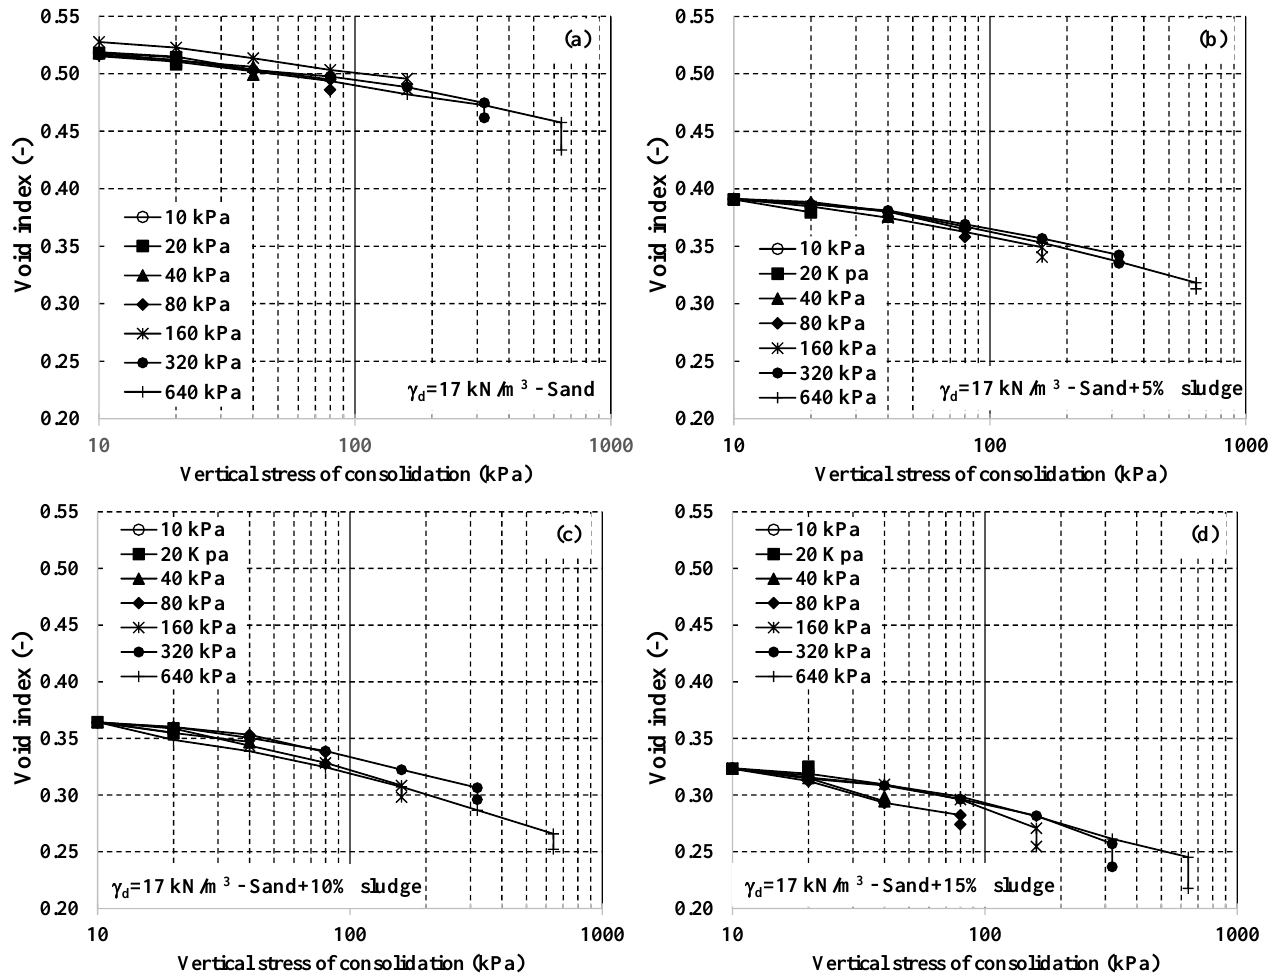
Figure 7. Variation of the void index with the vertical stress of consolidation obtained through single oedometer tests, for dry apparent specific weight of 17.0 kN/m 3 : ( a ) sand, ( b ) sand plus 5% sewage sludge, ( c ) sand plus 10% sludge, ( d ) sand plus 15% sludge.